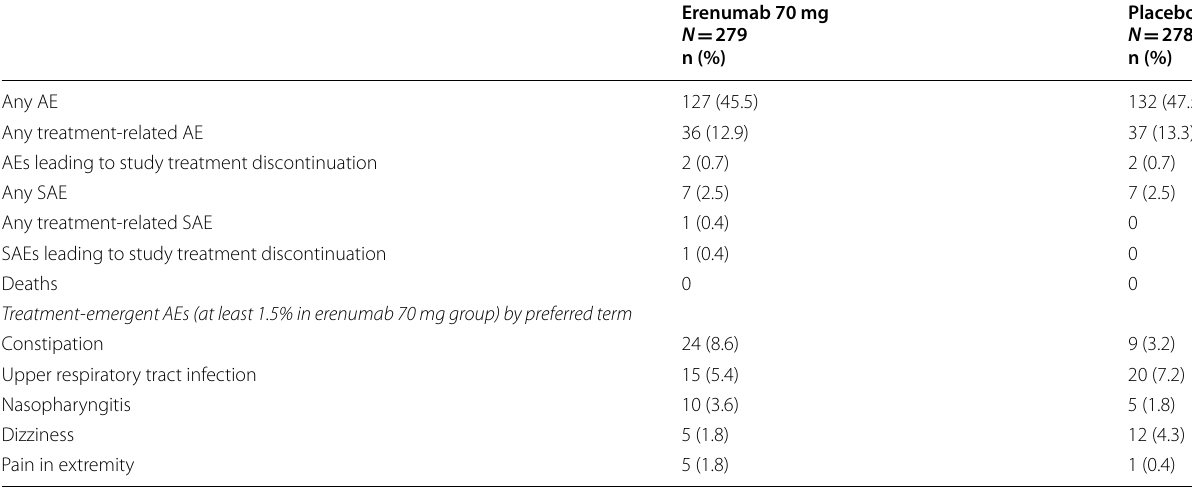
The P -values reported for the secondary endpoints (monthly acute headache medication days and mMIDAS) are nominal and should be interpreted with caution The secondary efficacy endpoints (change from baseline in monthly acute headache medication days and mMIDAS) were analysed using a generalised linear mixed effects repeated measures model similar to the primary endpoint CI, confidence interval; mMIDAS, modified migraine disability assessment; SE, standard error n Number of patients with non-missing value at the corresponding time point of interest Table 3 Summary of treatment‑emergent AE by preferred term ( 1.5% in erenumab group) during the DBTP (Safety analysis set) ≥